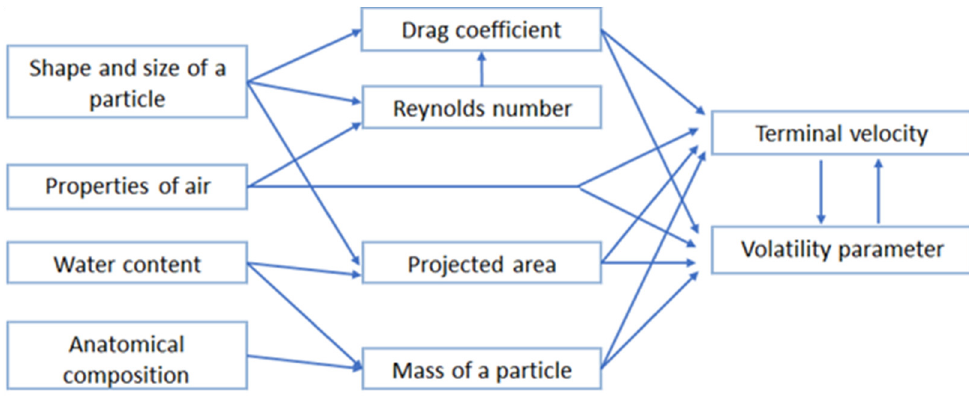
Figure 3. Influence of various factors on aerodynamic properties.